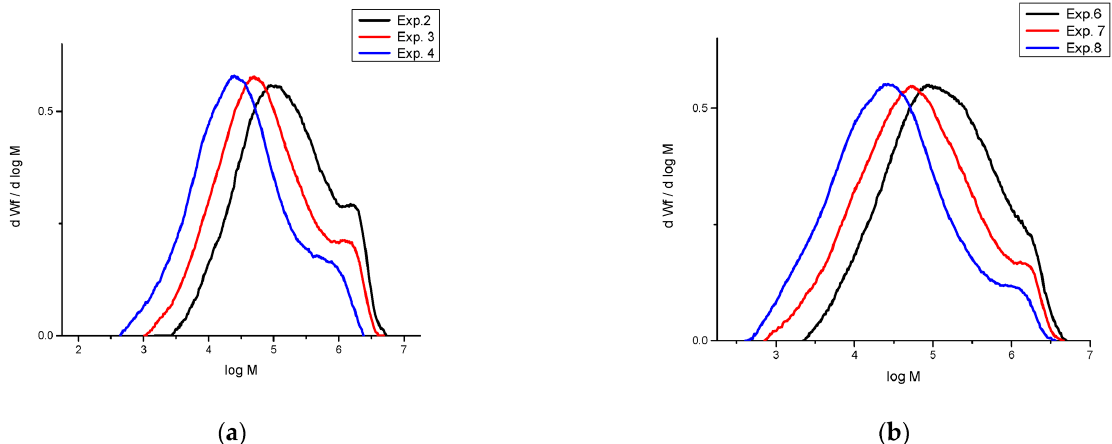
Figure 2. MWD curves of the polymers obtained on the “low-loading” (VC1, exps. 2–4) ( a ) and “high-loading” (VC2, exps. 6–8) ( b ) VMCs (polymerization conditions are listed in Table